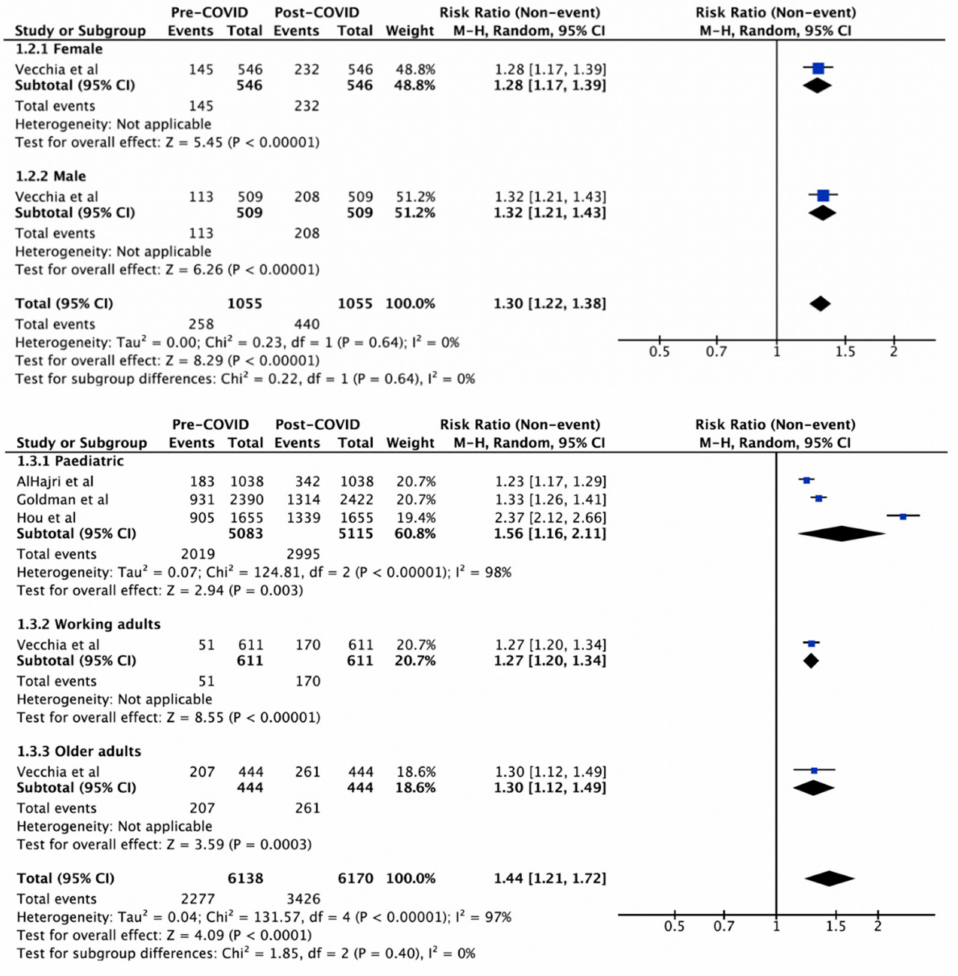
Figure 3. Influenza vaccination uptake pre-COVID-19 vs intention post-COVID-19 by gender and by age. The squares and rhombus represent the individual and pooled point effect estimates with 95% confidence intervals